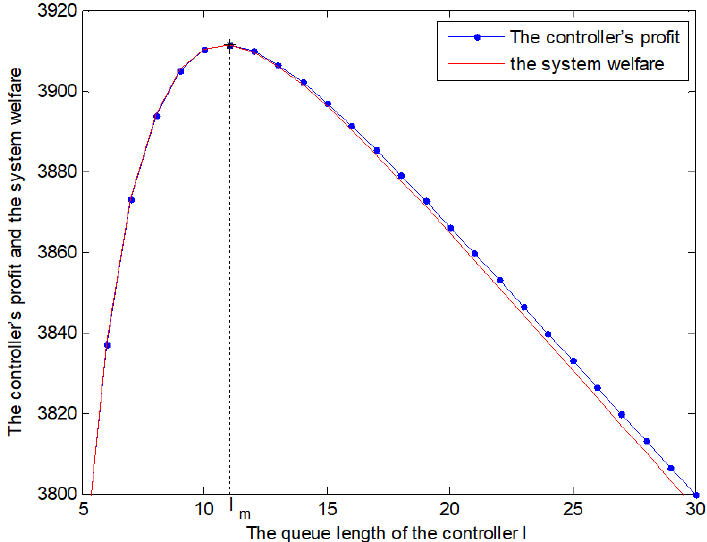
Figure 5. The controller’s profit and the system welfare with different queue